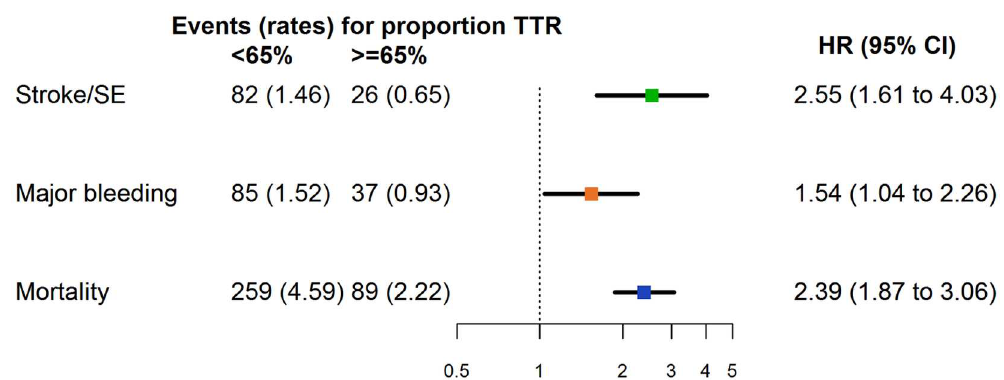
Fig 1. Incidence rates and adjusted hazard ratios for 1-year clinical outcomes according to proportion of time in therapeutic range. Reference group: TTR (cid:21) 65%. Incidence rates are per 100 person-years. CI, confidence interval; HR, hazard ratio; SE, systemic embolism; TTR, time in therapeutic range. HRs were controlledfor the followingpotential confounders: age group ( (cid:20) 64, 65–69, 70–74, (cid:21) 75 years), gender, smoking (no, ex, current), congestive heart failure, vascular disease, moderate-to-severe chronic kidney disease, diabetes mellitus, hypertension, previous stroke (not includedin the model for major bleedingevents), previous bleeding (not includedin the model for stroke/SE), antiplatelet treatment, type of atrial fibrillation, and area (Europe, Asia, other countries).